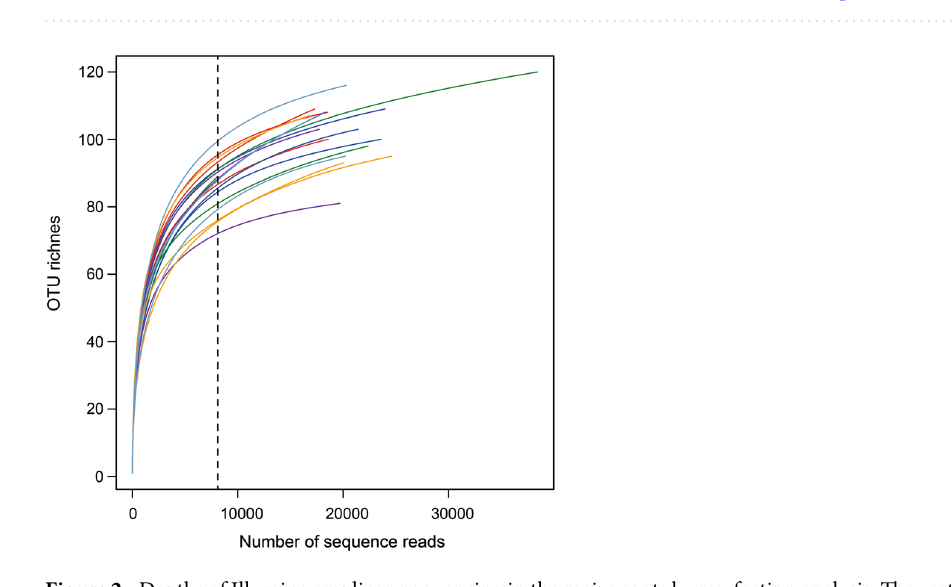
Figure 2. Depths of Illumina amplicon sequencing in the maize roots by rarefaction analysis. The vertical dashed line was placed at 8,104 sequences and the operational taxonomic units (OTUs) of arbuscular mycorrhizal fungi (AMF) were defined at a cut-off level of 8,104 reads. All analyses and Fig. 2 were run and created in the software environment RStudio (Version 1.2.1335 – © 2009–2019 RStudio, Inc.) (http://www.